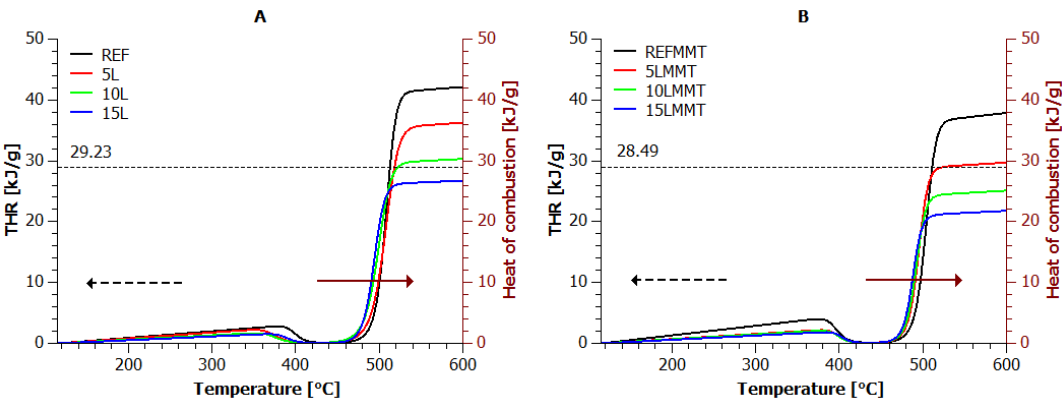
Figure 8. Comparison of the TG and MCC measurements by determining the heat of combustion as a function of temperature during the thermal decomposition of the PA6 samples (heating rate 1 ◦ C / min):